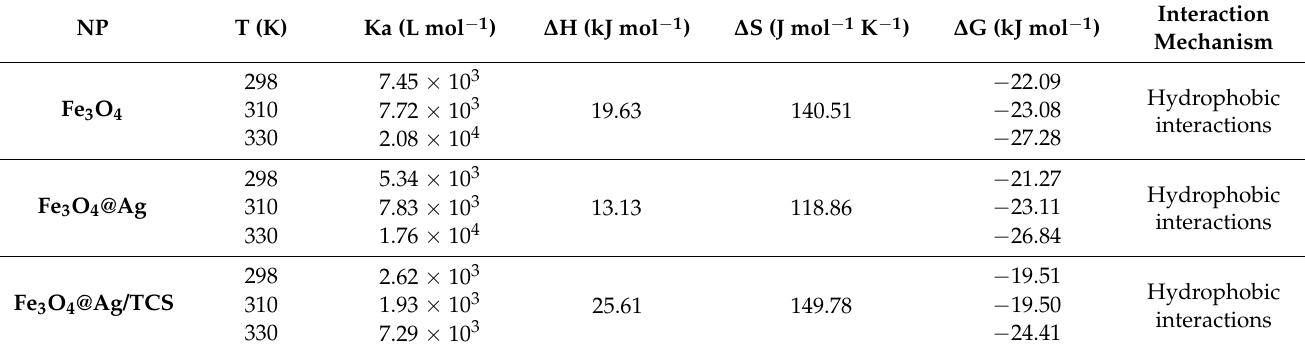
Table 3. Thermodynamic parameters of the NPs–albumin complex obtained from the graphs of Figure 5.